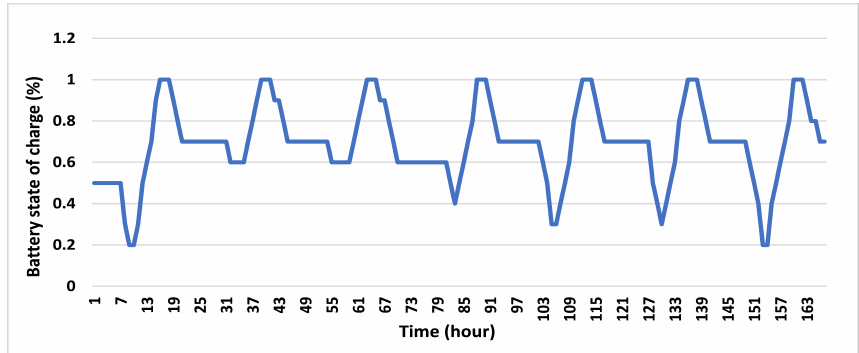
Figure 17. Battery state of charge during a week in the dry season: Case 3, Scenario 1. The results obtained for a week in the rainy season are displayed in Figure 18. The grid participates in meeting the load significantly, with a higher load in this season. Figure 19 portrays the SOC of the BESS. The highest load detected during this week was 546.8 kW. The values of battery, grid, and PV participation in load coverage are 139.7 kW, 372.3 kW, and 515 kW, respectively.